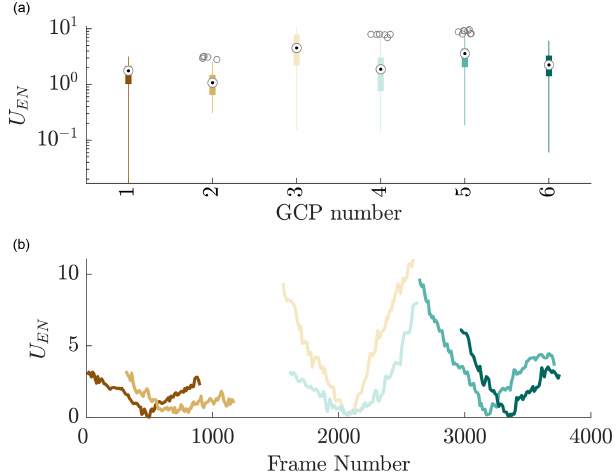
Figure 6. U EN indicates how the location of individual GCPs varies relative to the central position of the GCP throughout the stabilised image sequence. Time-averaged results are presented (a) in the form of box plots with U EN indicating the distance (px) of GCPs in in- dividual frames relative to the central position of the GCP. The lo- cations of GCPs were manually determined for every 10th frame in the stabilised image sequence. The variation of the GCP locations over time, relative to the central position, is provided in (b) . Line colours are consistent with the GCP numbers provided in (a)